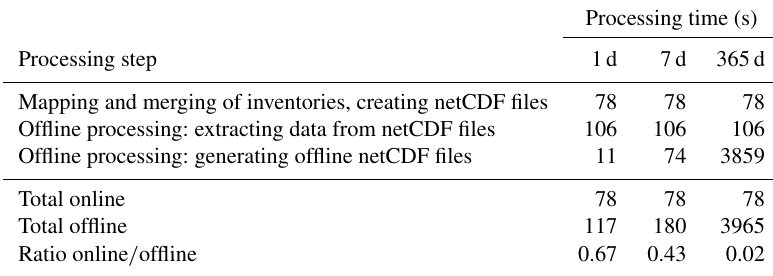
Table 6. Benchmark for pre-processing online and offline emissions for the COSMO-GHG test case using the emiproc tool. Altogether, 19 categories from the emission inventories were processed (TNO: 14; Swiss: 5) as input for the CO 2 tracer. Pre-processing was performed on a local Linux cluster, using 14 threads in parallel. Processing times for generating the mapping and country mask files are excluded. Results are shown for different dataset